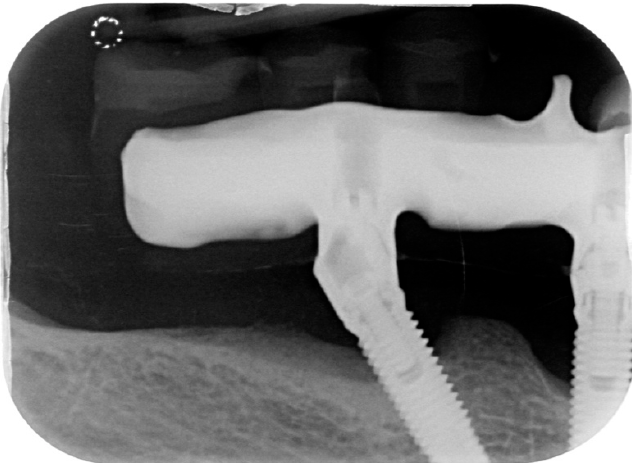
Figure 2. Periapical radiograph belonging to the only diabetic patient who developed peri-implantitis.